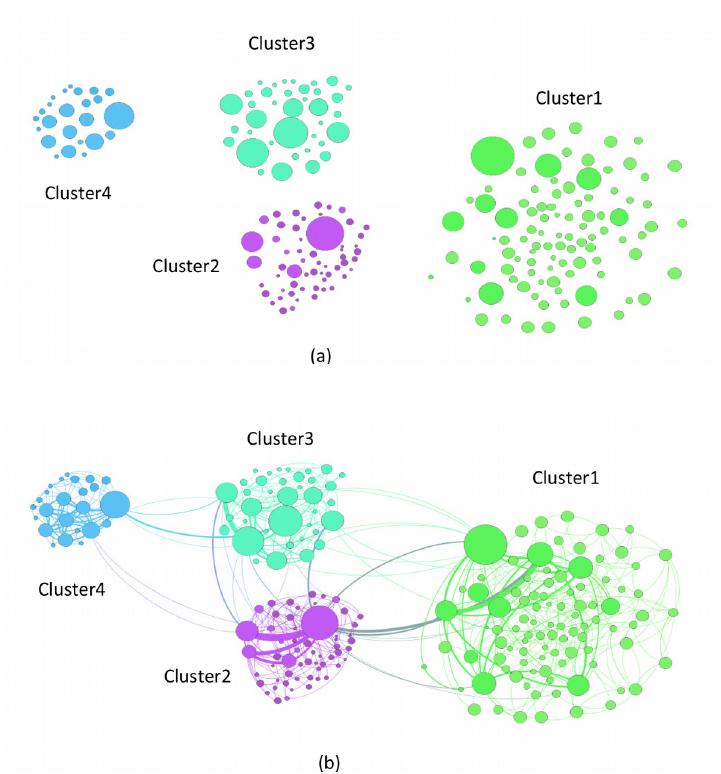
Figure 4. (a) The positioning of the four clusters without arc, (b) The positioning of the four clusters with